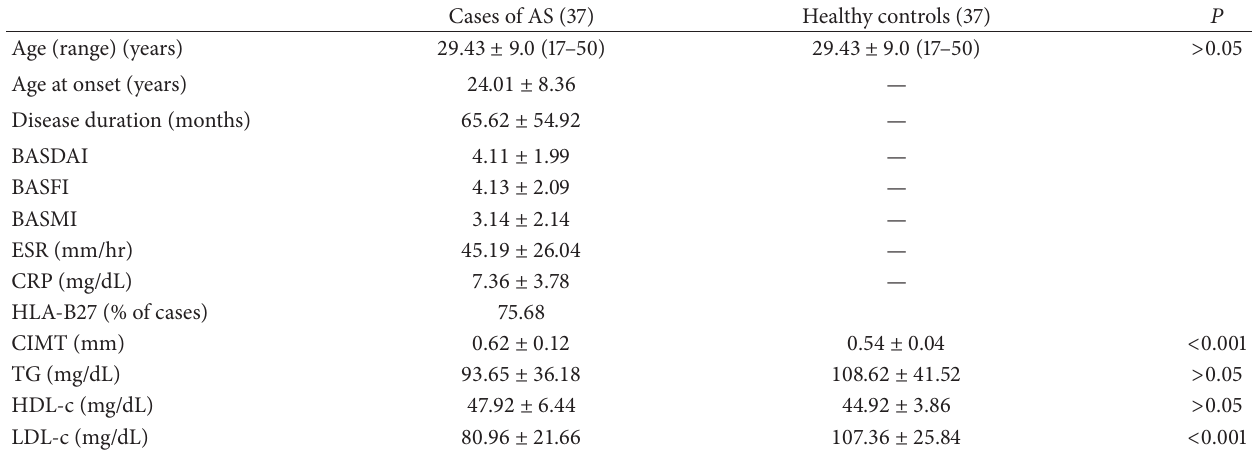
Table 1: Characteristics of study